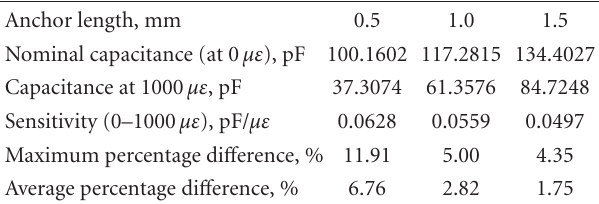
Table 5: Analysis outcome for di ff erent anchor length. Anchor length, mm